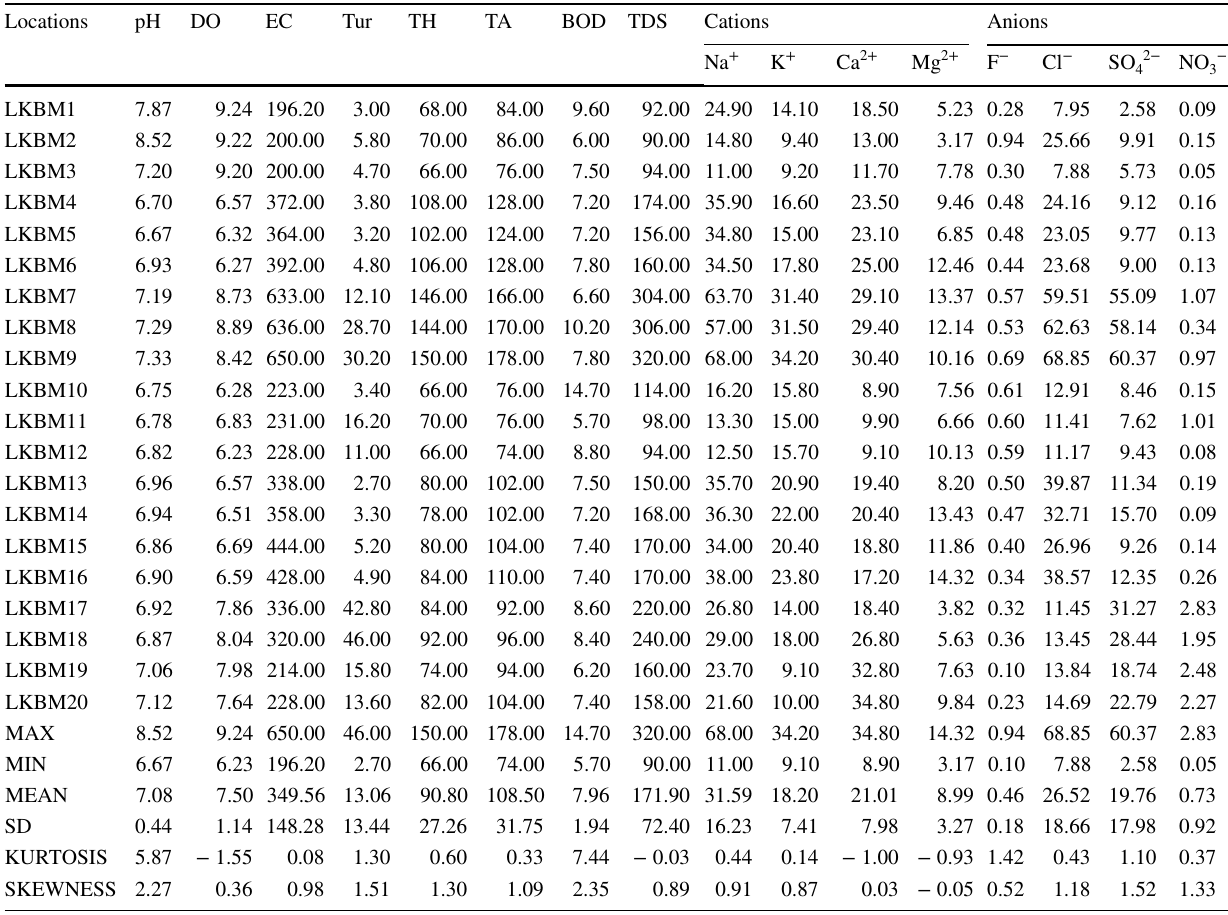
Table 5 Descriptive statistics of physicochemical parameters in post-monsoon season at North Guwahati Locations